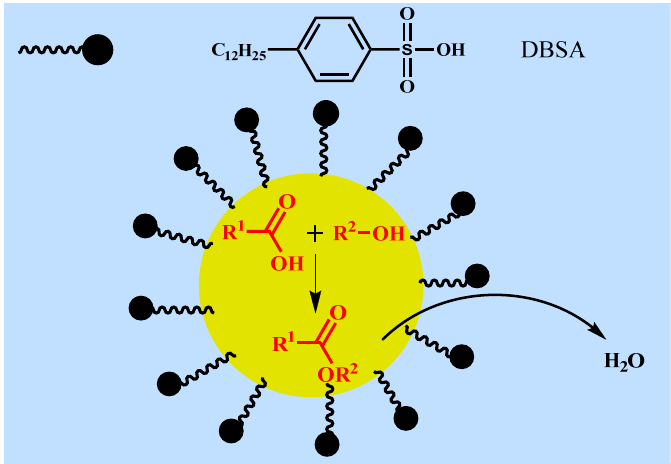
Figure 8. Proposed mechanism of the DBSA-catalyzed esterification.